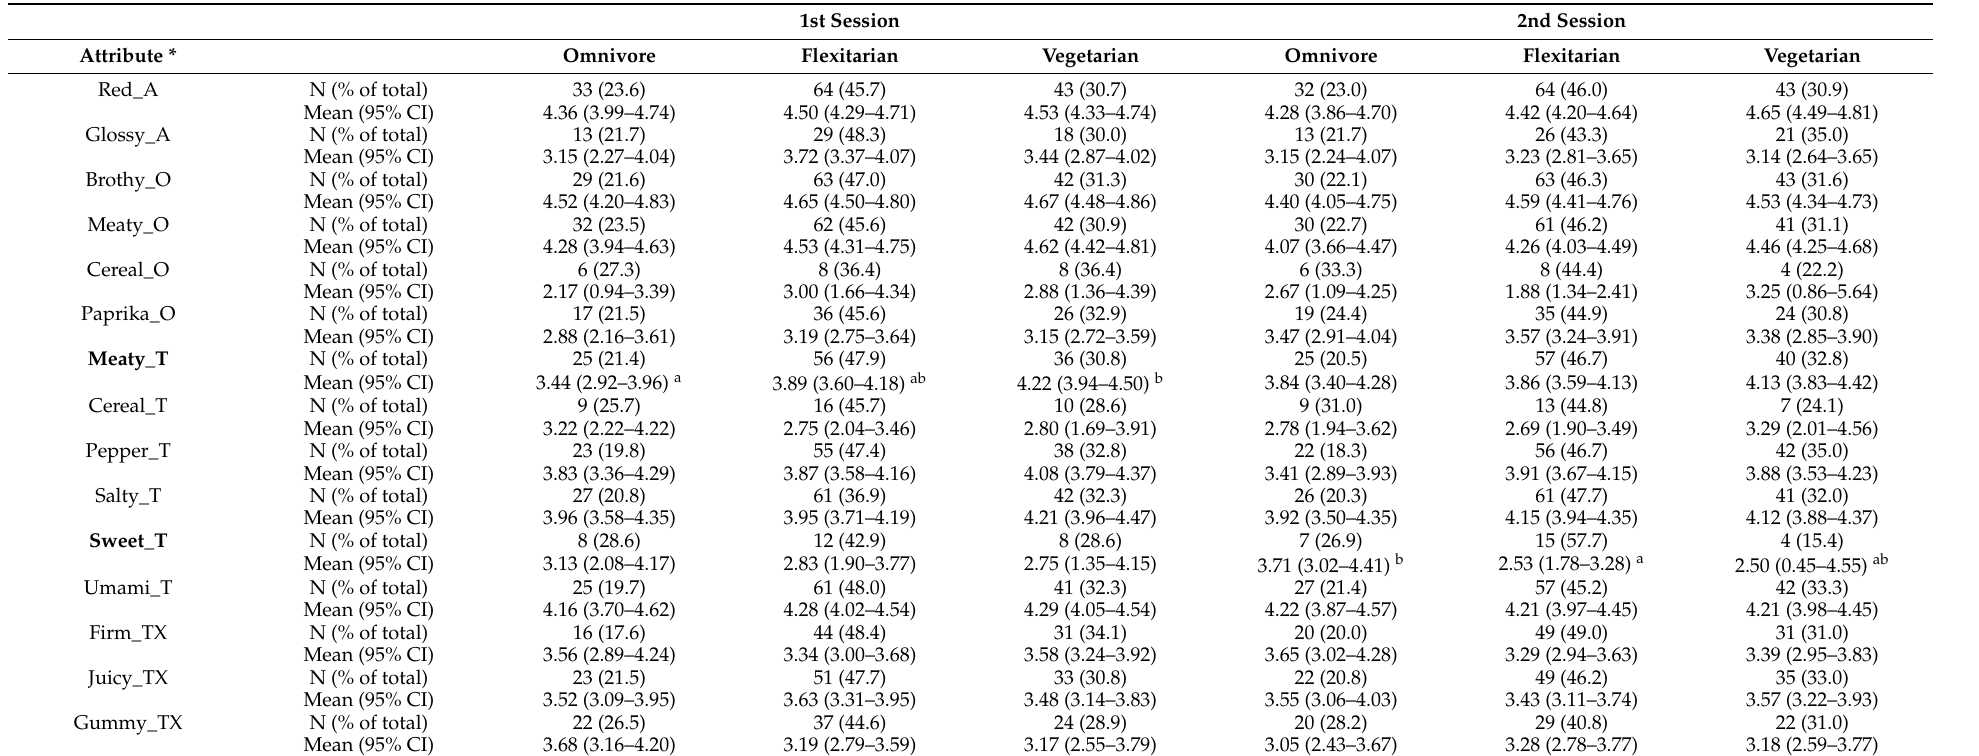
Table 4. RATA attribute evaluation of plant-based salami in two sessions on a 5-point scale, with different shares of 159 participants. Significant differences could be calculated for the attributes in bold , without the vegan nutrition